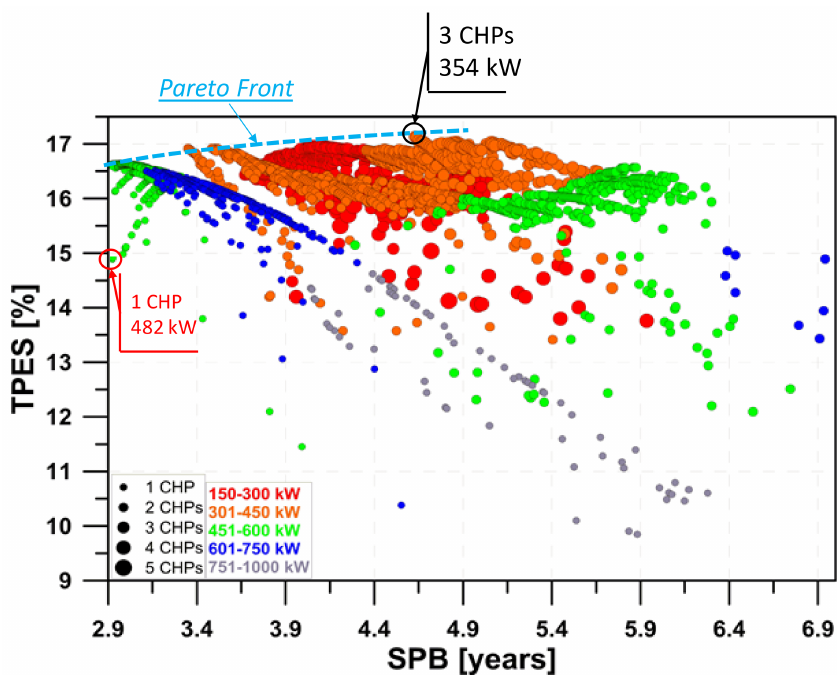
Figure 6. Bubble chart with details concerning CHP engine number and